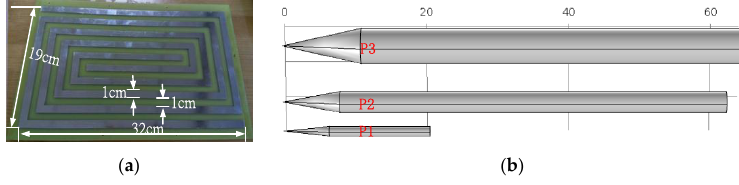
Figure 13. ( a ) Prototype of the spiral electrodes and ( b ) schematic view of three projectiles. Table 1. The size of the three projectiles.